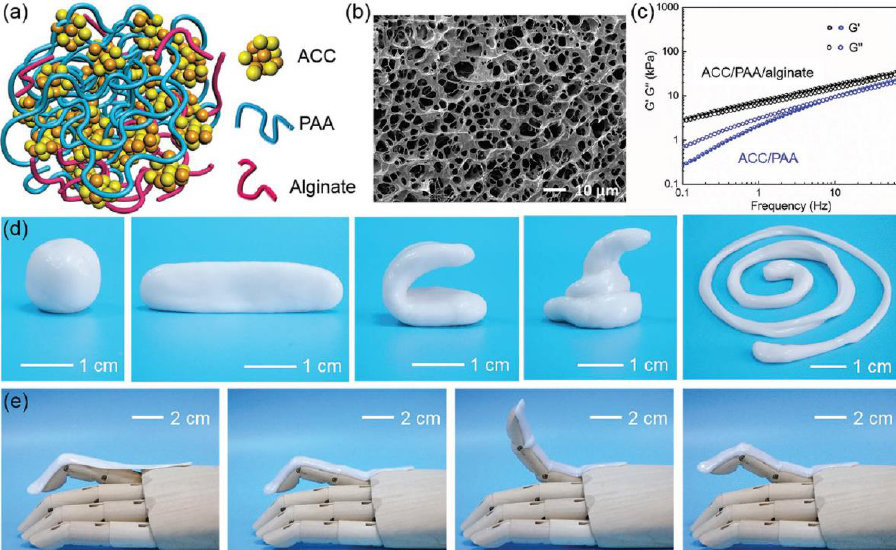
Figure 11. ( a ) Schematic structure of the ACC / PAA / alginate mineral hydrogel. ( b ) SEM image of the freeze-dried ACC / PAA / alginate hydrogel. ( c ) Frequency dependencies of the storage (G’) and loss (G”) moduli of the ACC / PAA / alginate and ACC / PAA hydrogels. ( d ) The ACC / PAA / alginate